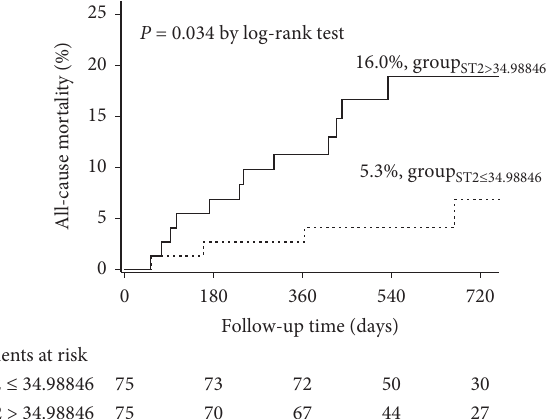
Figure 1: Kaplan–Meier curves for all-cause mortality according to the median levels of sST2.